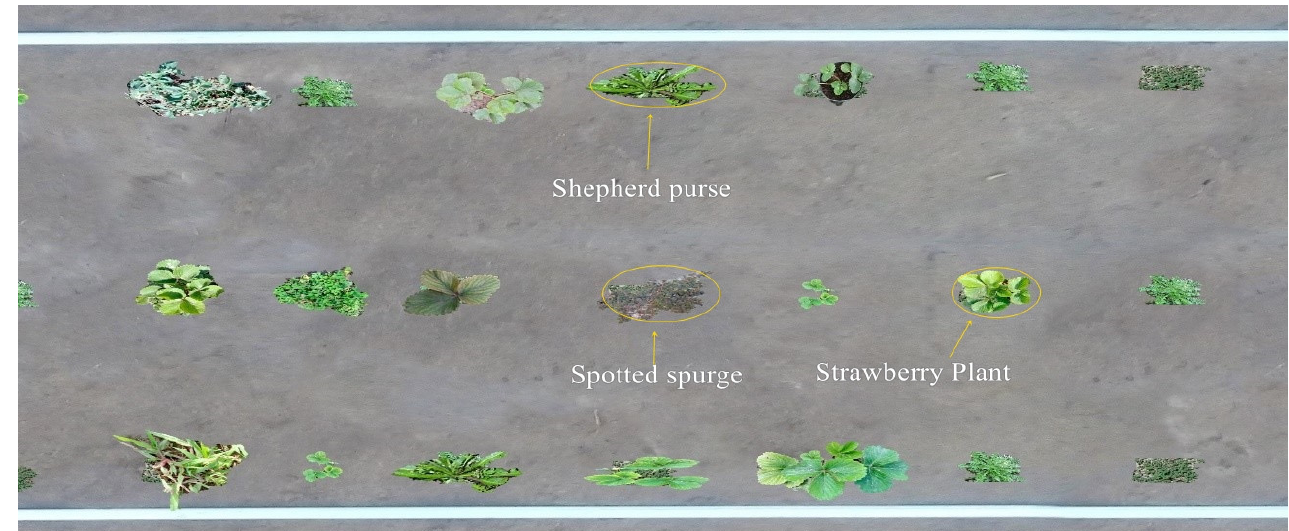
Figure 5. Design of laboratory experiment trajectory for testing spraying